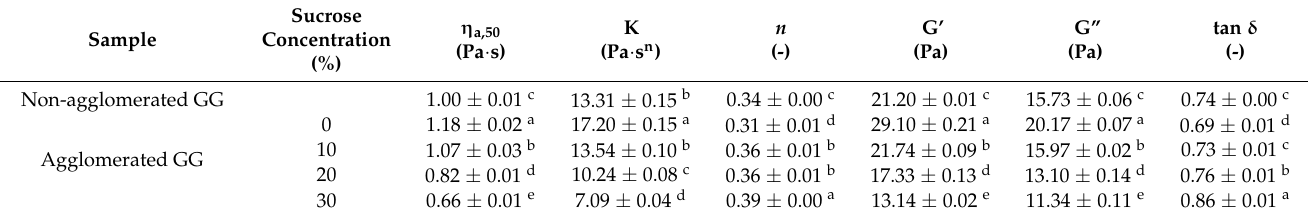
Table 2. The magnitude of power-law model parameters ( η a,50 , K, and n ) and dynamic rheological parameters (G’, G”, and tan δ ) of non-agglomerated and agglomerated guar gum (GG) with various concentrations of sucrose